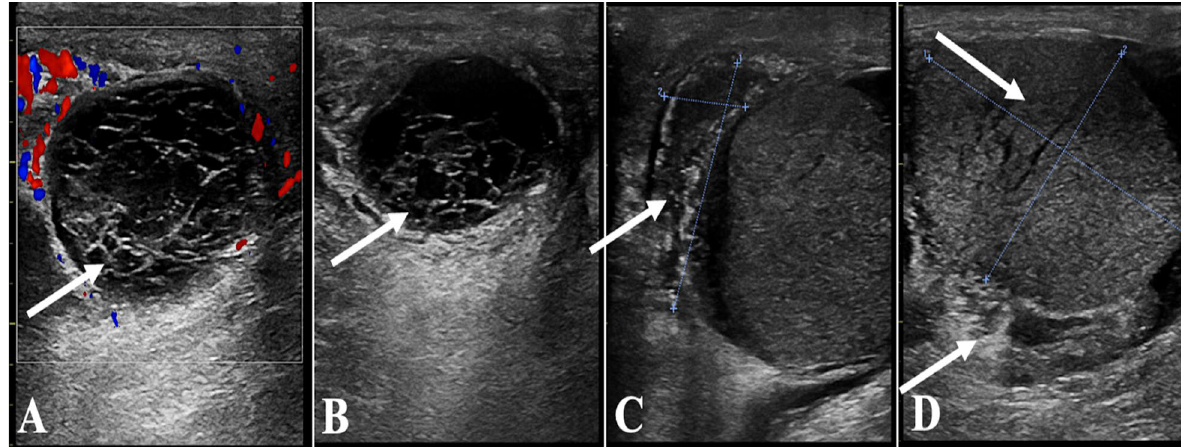
Fig. 1 Extensive complex fluid collection and septation and heterogeneous with increase blood flow seen in A and B, this indicated large size pyocele (white arrows). Severe inflammation of epididymis (left epididymis is enlarged to 4.9 4.1 1.7 cm) and orchitis are observed in C and D (white ×